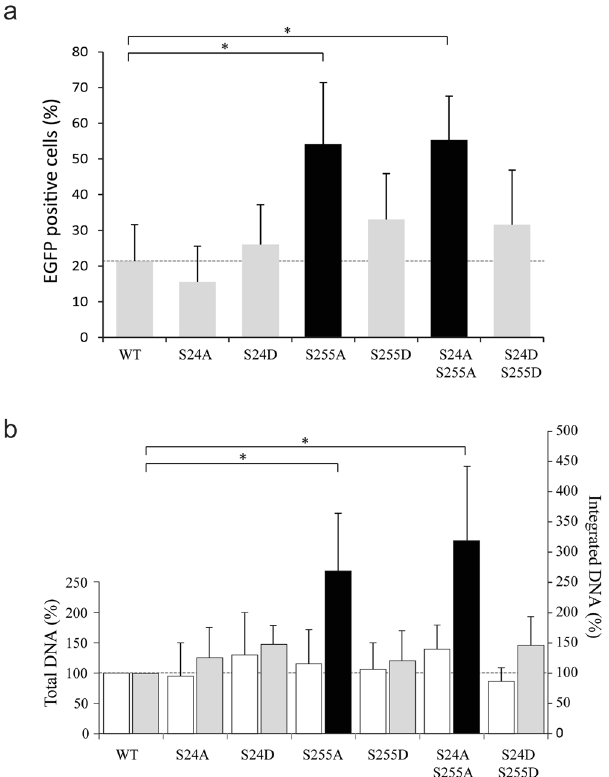
Figure 5. Effect of mutations on infectivity. Transduction efficiency of 293 T cells using WT and mutant vectors at a MOI of 1 was determined by measure of EGFP expression by flow cytometry ( a ) and by qPCR to quantify total and integrated viral DNA ( b ). The results derived from the mean of at least three independent experiments. Student’s t -test * p <